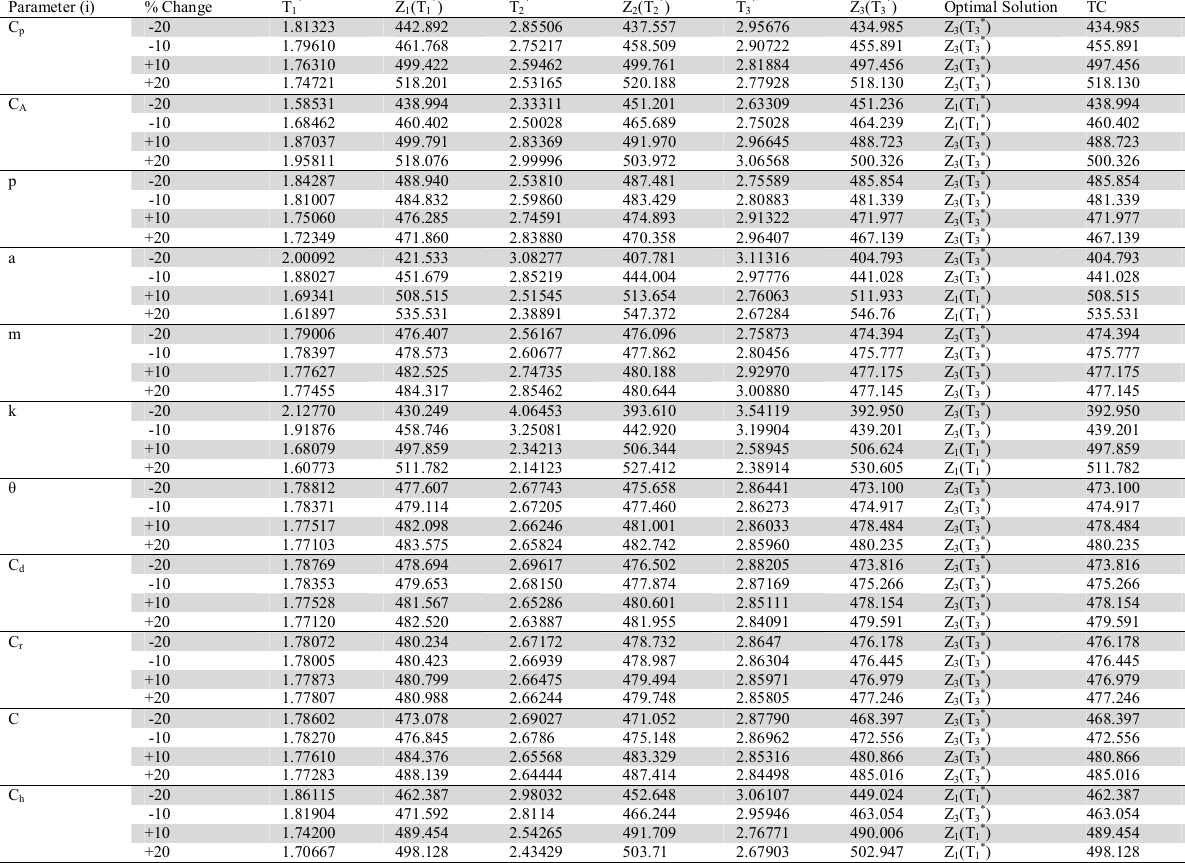
(For example (2)) The effect of changing the parameter ( i ) while keeping all other parameters unchanged Parameter